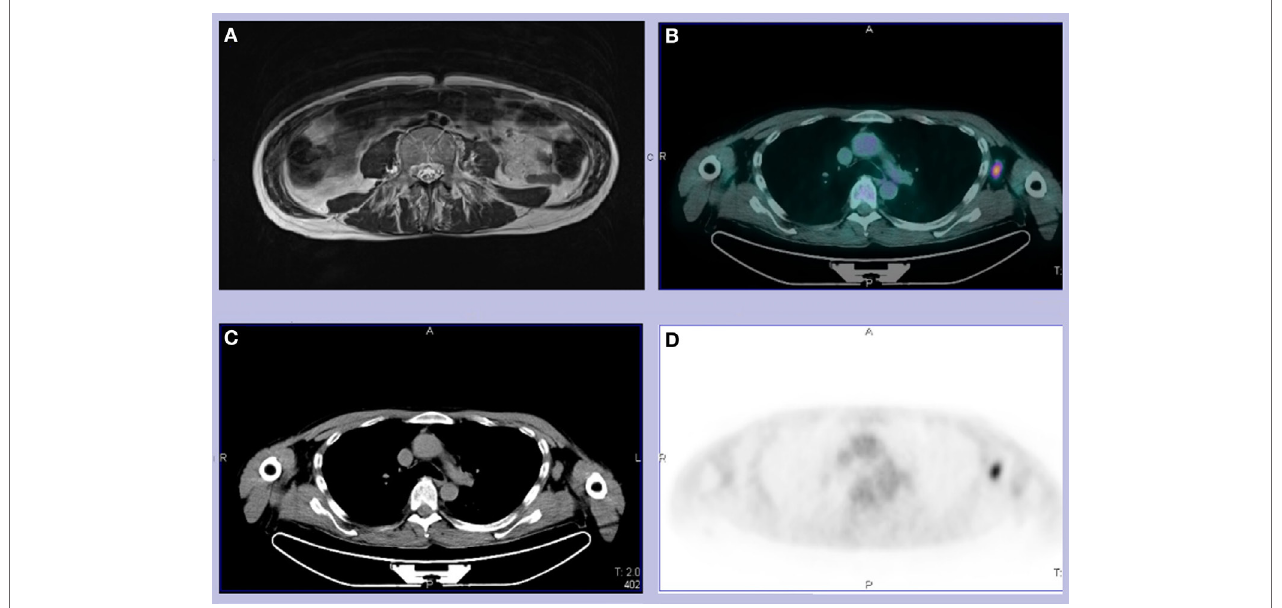
FIGURe 1 | (a) T2 abdominal MRI revealing left psoas and bilateral paravertebral muscles edema and fatty substitution. (B–D) Total body CT-PET showing a hypermetabolic left axillary lymph node. We did not use copyrighted material from other sources (including the web).